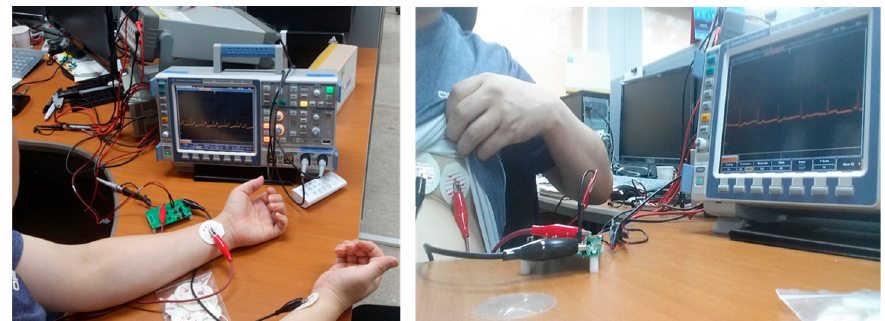
Figure 9. Testing the ECG signals from the wrists and chest.